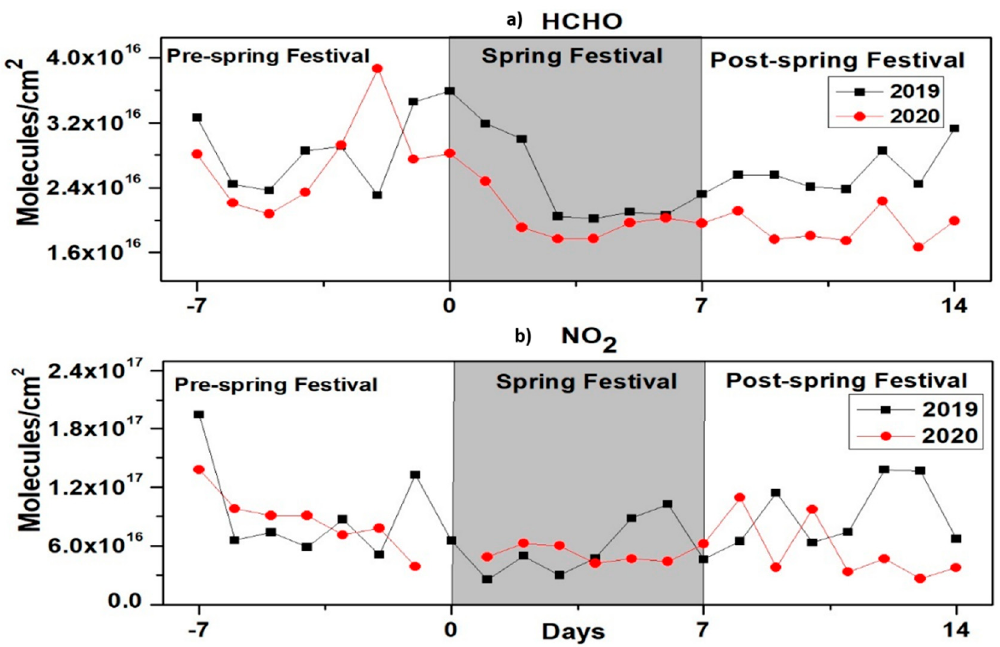
Figure 8. Impact of Spring Festival holidays on the vertical column densities (VCDs) of ( a ) nitrogen dioxide (NO 2 ) and ( b ) formaldehyde (HCHO) over Shanghai .